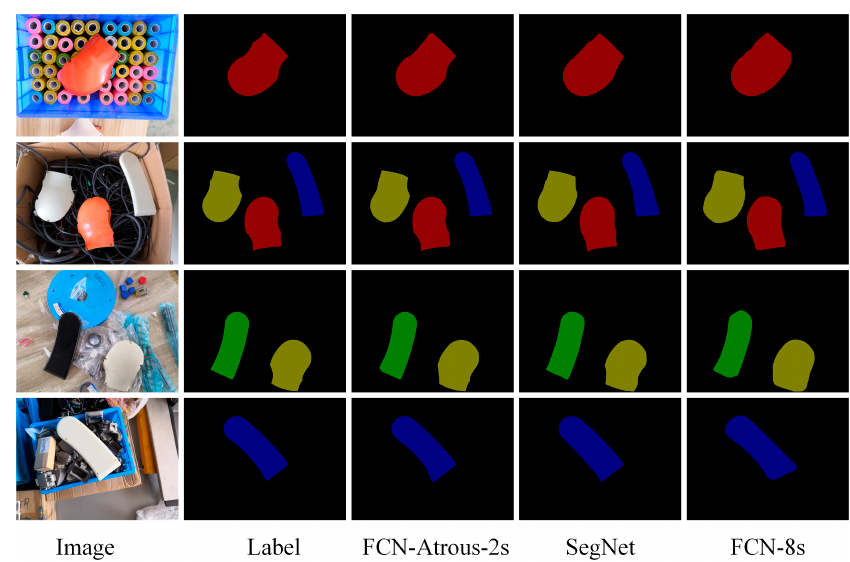
Figure 5. Comparison of semantic segmentation results. The segmentation results of the FCN-8s and Segnet are smoother to cover the original shape features in places where the object boundary changes are greater than FCN-atrous-2s. In comparison, the segmentation results of the FCN-atrous-2s are more elaborate, which shows the variation characteristics of the boundary and which are closer to the result of the Label. Table 1. The performance of the Neural Networks for Semantic Segmentation Neural